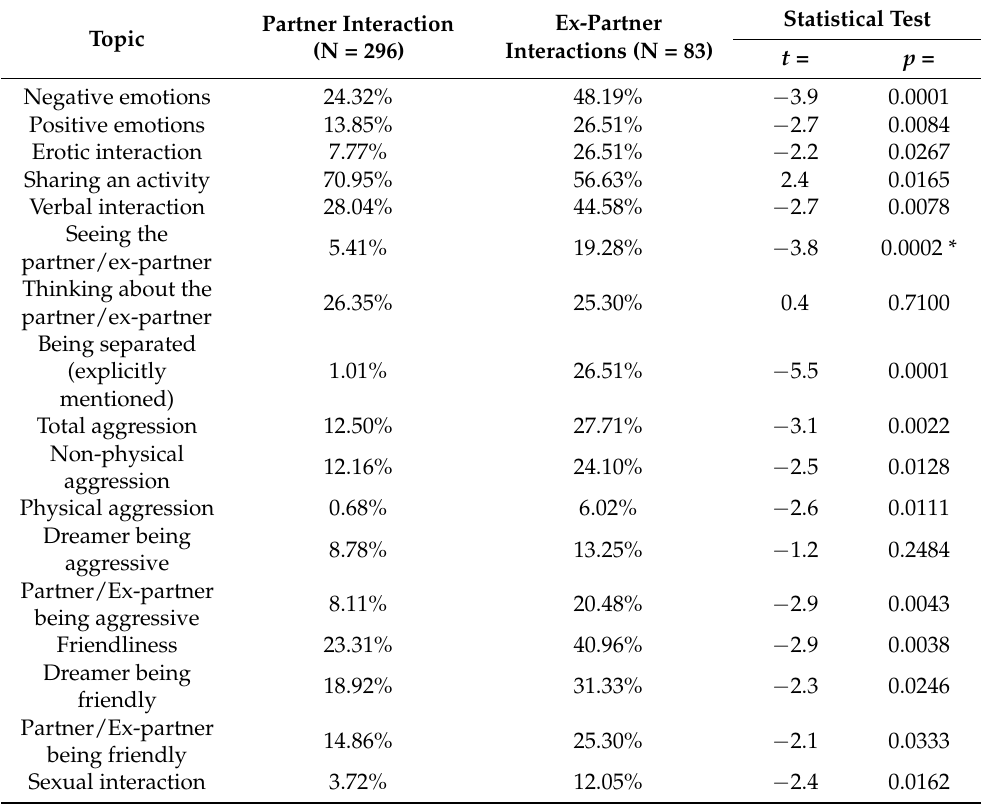
Table 3. Interactions between dreamer and partner and ex-partner within the